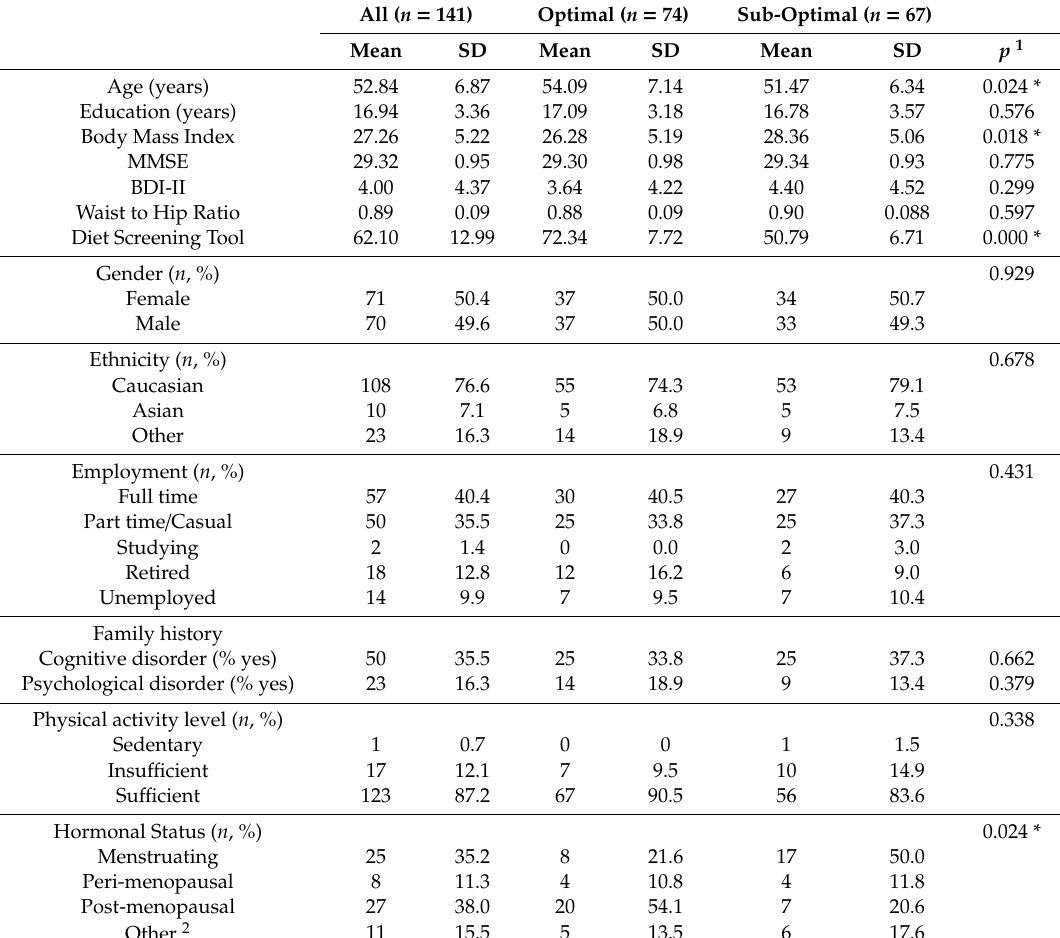
Table 1. Characterization of sample for all participants and by diet quality